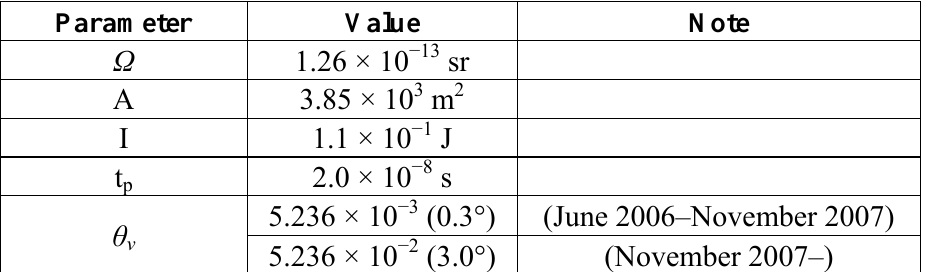
Table 1. CALIOP lidar-specific parameters for Equation